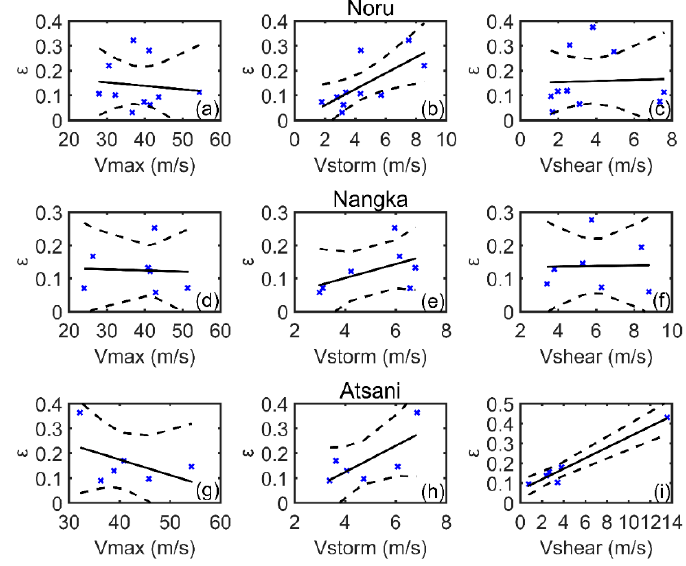
Figure 14. Asymmetry parameter ( ε ) versus TC intensity ( V max ), translation speed ( V storm ), and environmental vertical wind shear magnitude ( V shear ) for Noru ( a – c ), Nangka ( d – f ), and Atsani ( g – i ). Black solid and dashed lines represent linear regressions and 95% confidence intervals for the fits, respectively.